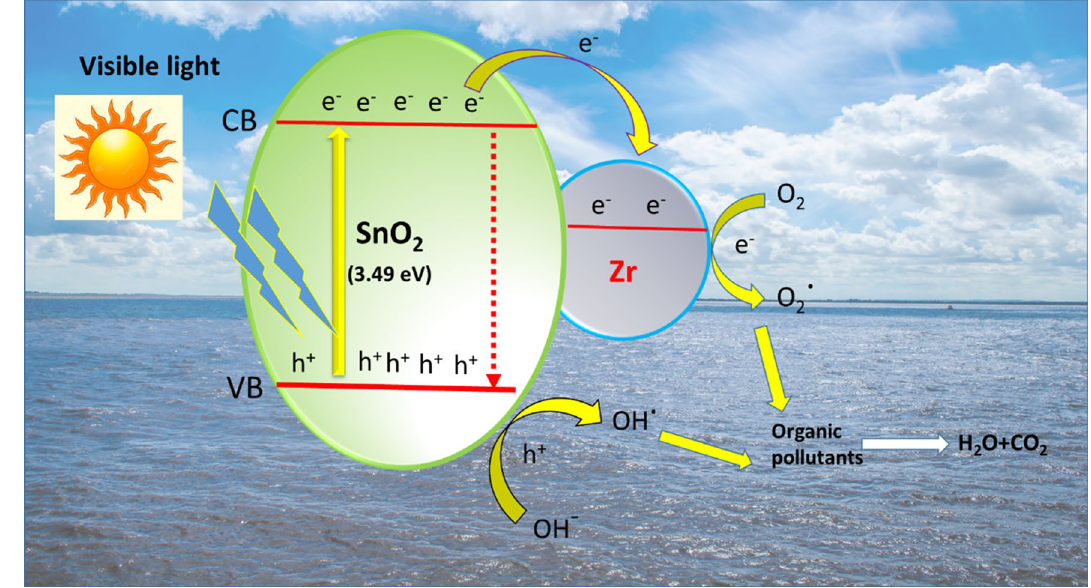
Fig. 14 The plausible mechanism of the MO dye degradation for 4% Zr-doped SnO